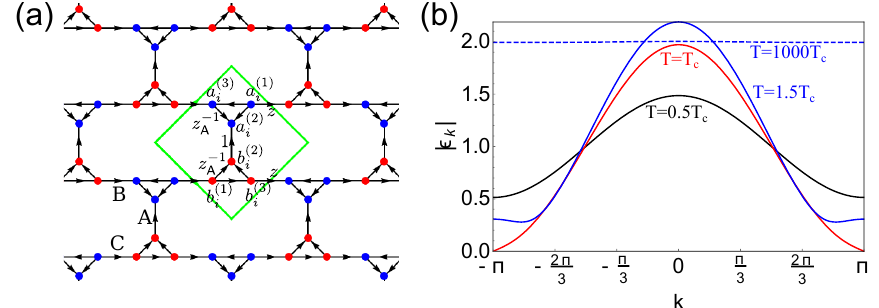
| [ Eq. 60 ] used to calculate the partition Figure 19: The extended brick lattice and spectrum | ε k function of H ABB [ Eq. 32 ] in the unconstrained manifold. (a) Bond directions (black arrows) are chosen so as to respect Kasteleyn’s theorem [ 46 ] , and bond weights are chosen to be z on B and C bonds, 1 on A bonds and z − 1 on “extra” bonds, in accordance with Z exhon [ Eq. 55 ] . The i th unit cell A (green) contains 6 sites with associated Grassmann variables a ( 1 ) , a ( 2 ) and a ( 3 ) (blue) and b ( 1 ) , b ( 2 ) and i i i i i b ( 3 ) (red). The translation vectors of the unit cell are ˆ e x and ˆ e y (see Fig. 16), and these are taken to be i | [ Eq. 60 ] along the path k = ( k , k + π ) for J = 1 and J = 1.5. unit length. (b) The spectrum | ε 1A 1B k For T < T c (black) the spectrum is gapped at all k , and this corresponds to the stripe-ordered phase. At T = T c (red) the gap closes at k = ( π ,0 ) and an Ising transition occurs. For T > T c (blue) the gap | is at k = ( π ,0 ) . For T > T reopens. For T c < T < T Is the minimum of | ε Is the minimum migrates k away from k = ( π ,0 ) . In the limit T → ∞ the spectrum becomes